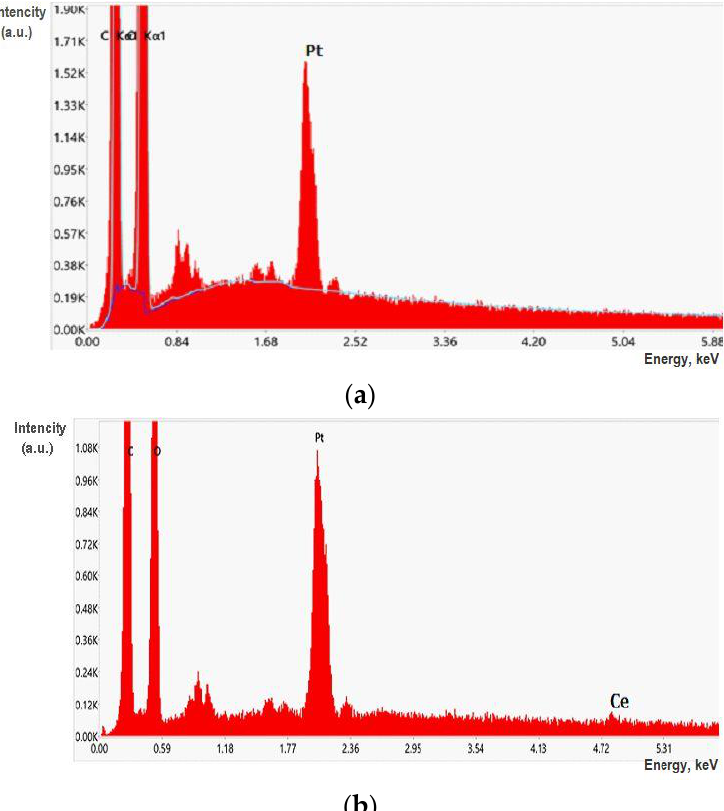
Figure 4. EDX spectra registered on the BC–ALG–CS film ( a ) and the BC–ALG(CeONP)–CS film ( b ).